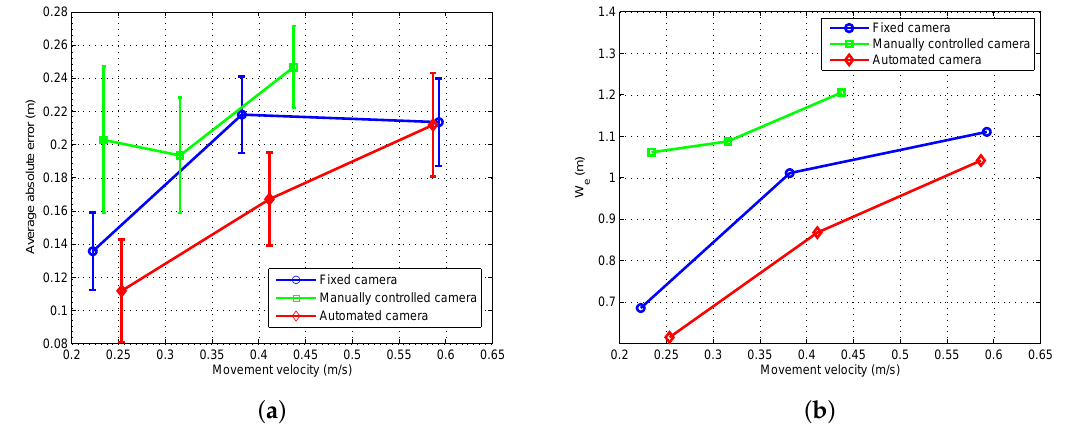
Figure 26. Comparison of task difficulty for different teleoperation configurations. ( a ) Error versus speed comparison. ( b ) Effective width versus speed